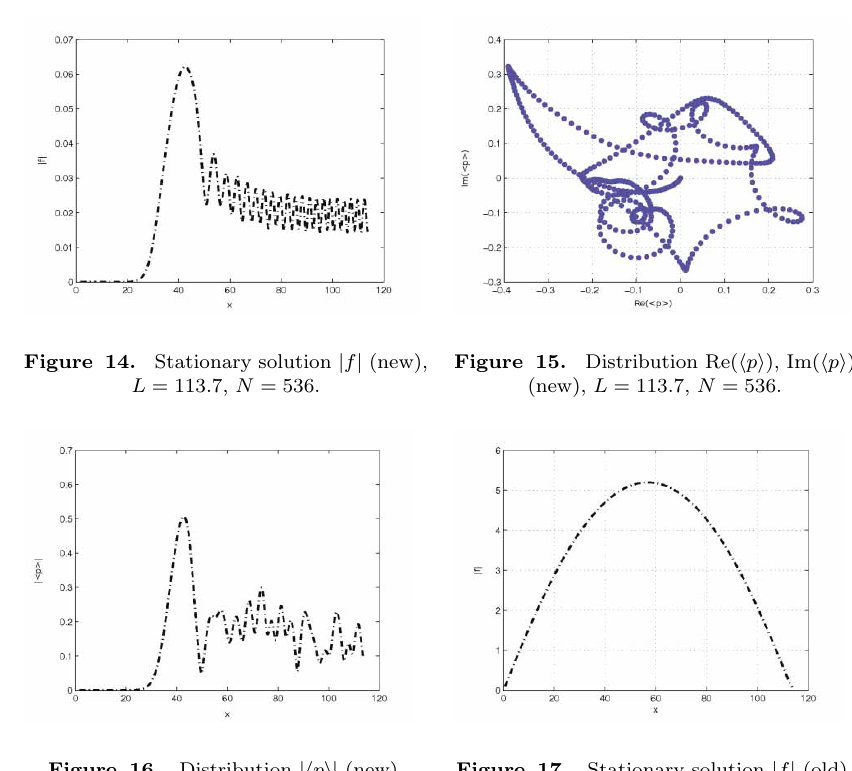
Figure 16. Distribution |(cid:5) p (cid:6)| (new), L = 113 . 7, N = 536.